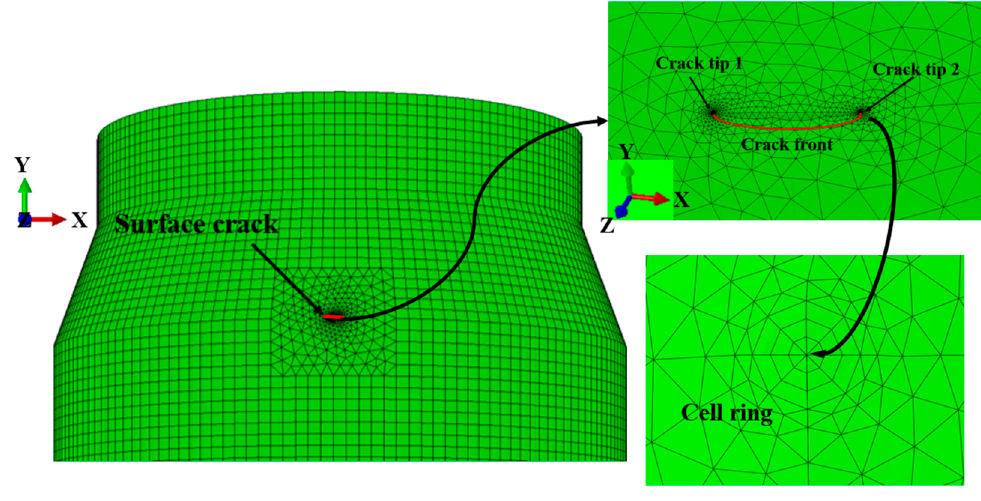
Figure 6. The location of the crack in the model.